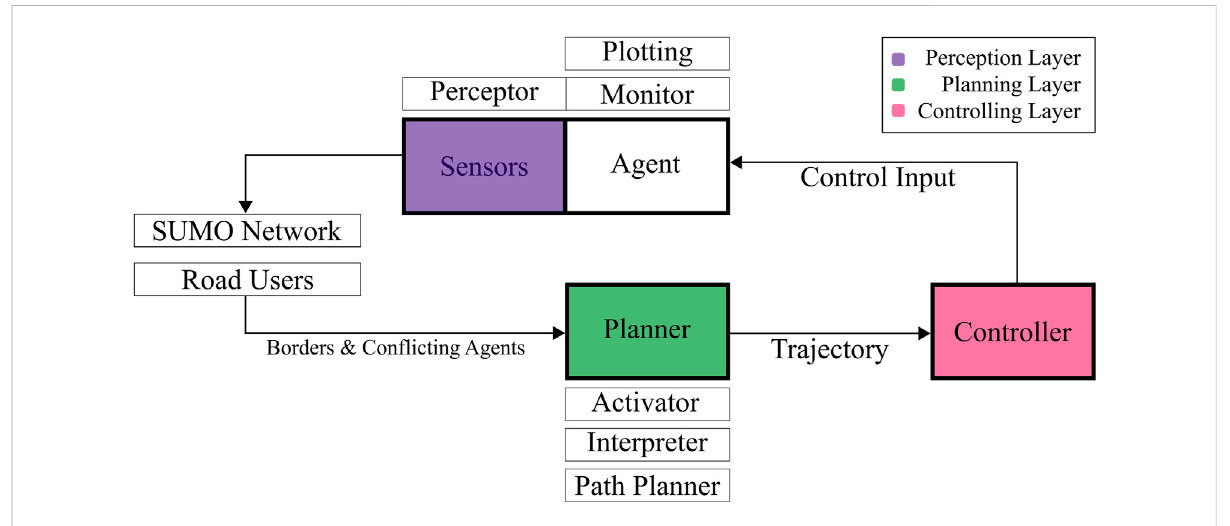
FIGURE 2 The developed Controlling Unit layout of the autonomous